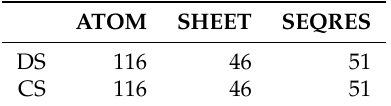
Table 2. Extraction time (s) for various sections of the PDB files for 3D protein structures stored in compressed (CS) and decompressed (DS) sequential files (data set DS1) for the execution with one allocation unit (AU). ATOM SHEET SEQRES DS